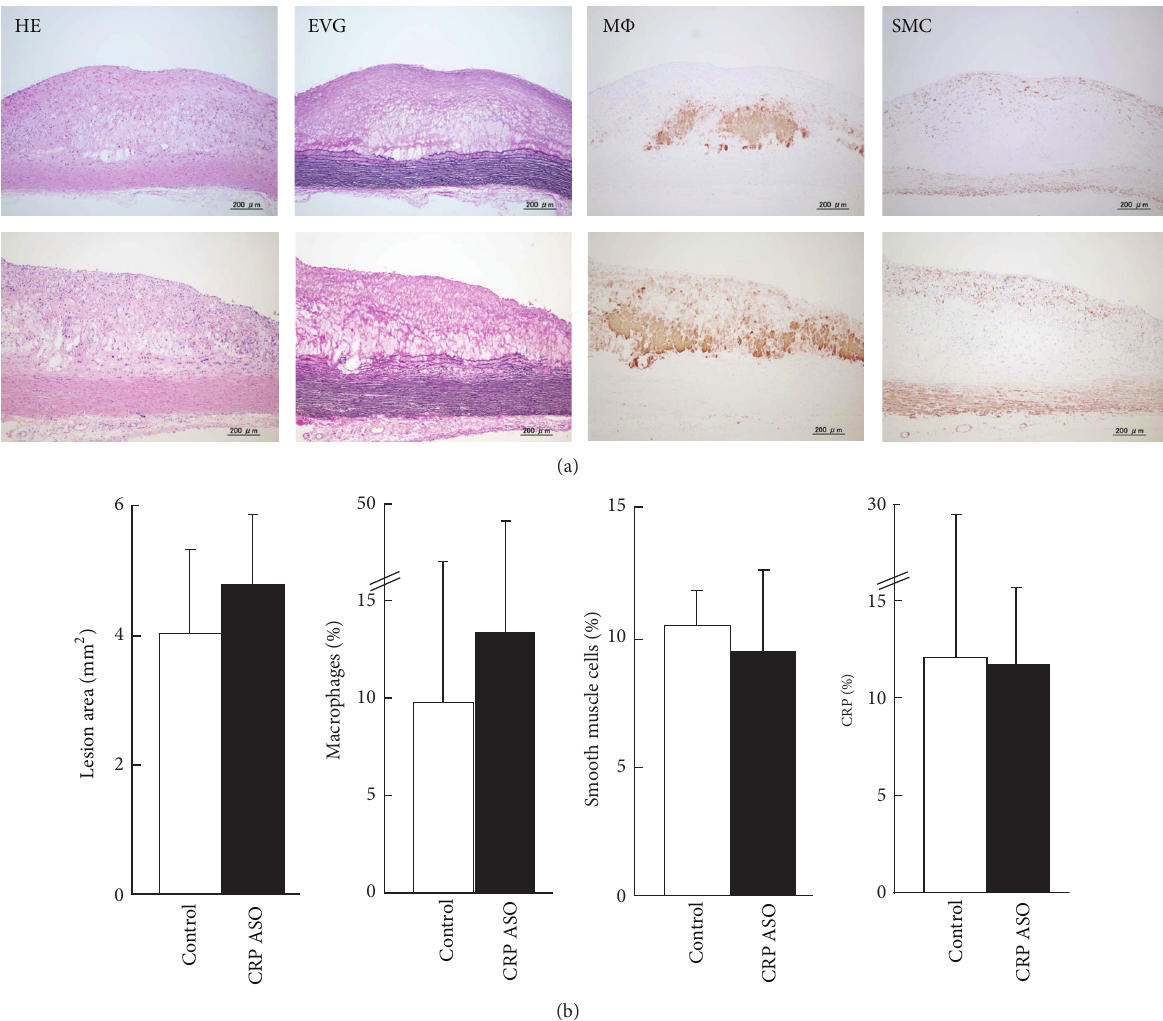
Figure 5: Microscopic analysis of the aortic lesions. Representative micrographs of the aortic lesions from CRP ASO-treated and control rabbits (a). Serial paraffin sections were stained with hematoxylin-eosin (HE) and elastica van Gieson (EVG) or immunohistochemically stained with monoclonal antibodies (mAbs) against either macrophages (M 𝜑 ) or 𝛼 -smooth muscle actin for smooth muscle cells (SMC) or rabbit CRP. Intimal lesions on EVG-stained sections and positively immunostained areas of macrophages; SMC and CRP were quantified with an image analysis system (b). 𝑛 = 9 for each